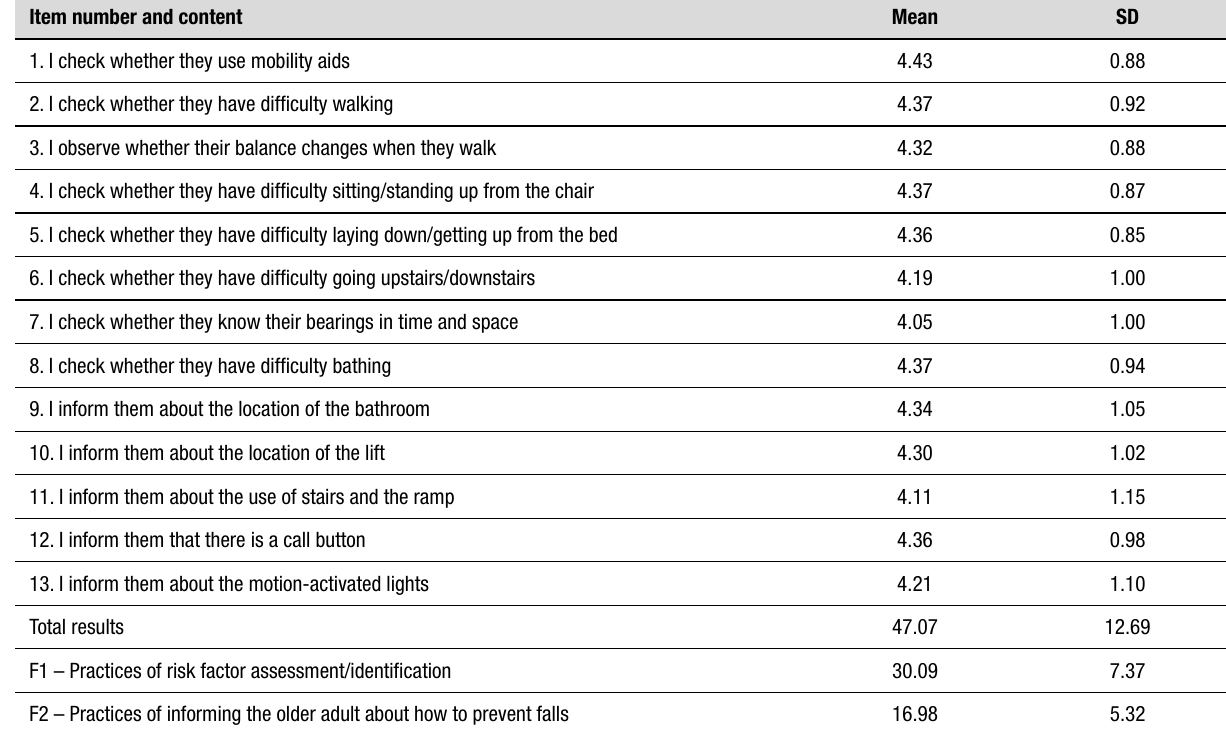
Table 3. Characterization of the older adult sample as to the identification of and information provided on risk factors during their admission. Lisbon, Portugal. Item number and